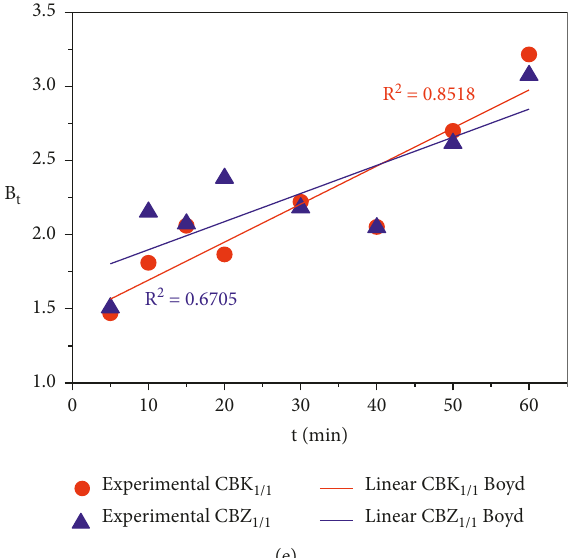
Figure 12: Linear regression of adsorption kinetics of (a) pseudofirst order, (b) pseudosecond order, (c) Avrami, (d) intraparticle diffusion, and (e) Boyd.